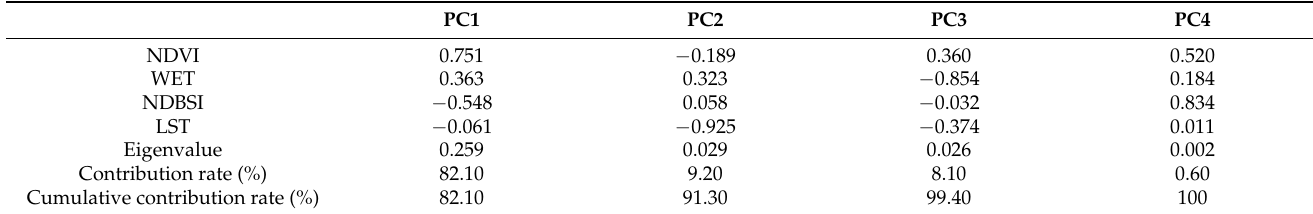
Table 3. Principal component analysis results of remote sensing ecological index in 2000.